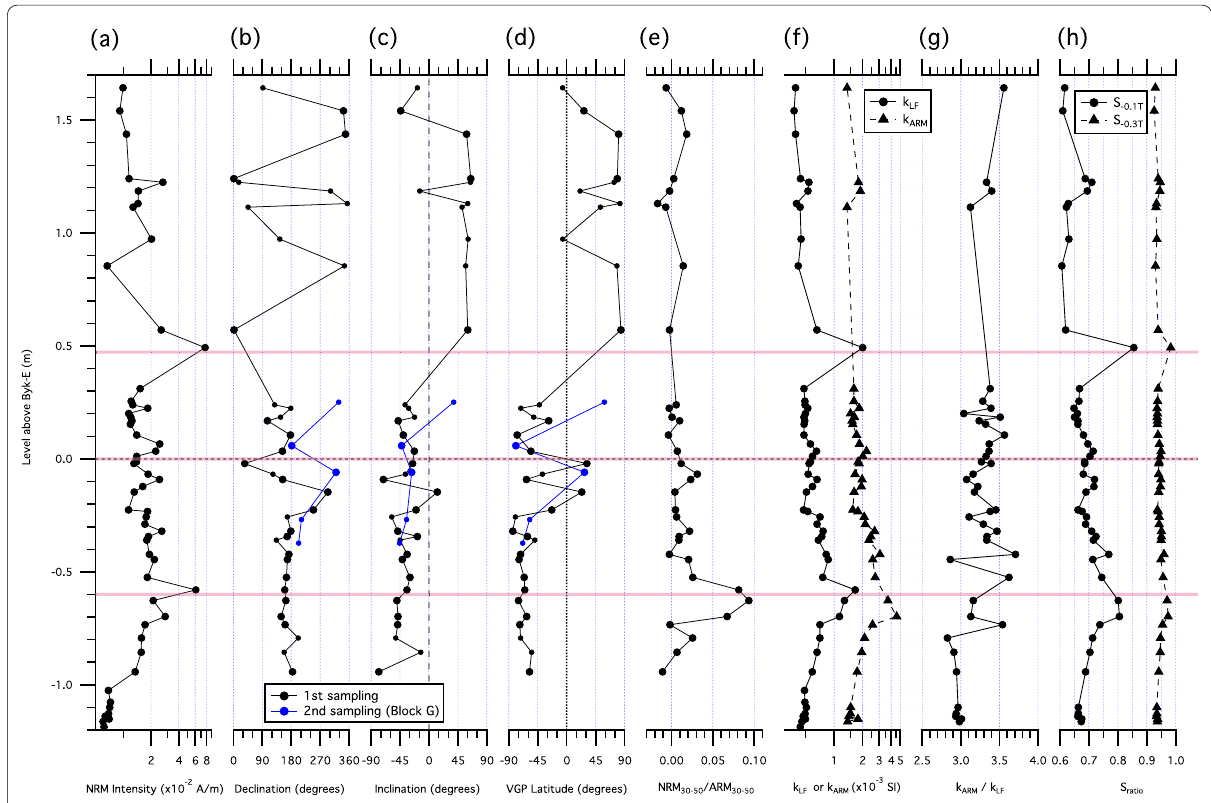
Fig. 14 Paleomagnetic results of combined analyses (Additional file 7: Table S2) plotted versus level above or below the Byk-E key tephra layer (corrected for the slope of the outcrop) together with various rock magnetic parameters. From left to right, a NRM intensity, b declination, c inclination, d VGP latitude, e relative paleointensity, f k LF (solid circles) and k ARM (solid triangles) g k ARM / k LF , h S ratio ( S circles and solid triangles, respectively). Black symbols are the results for the 1 st sampling and the blue ones are those for the 2nd sampling (Block G in Additional file 3: Figures S3(c) and S4(e)). In b – d , reliability categories are expressed by the size of the symbol (the largest is the most reliable category ‘3’). Horizontal pink lines are tephra layers, which correspond to tephra A, Byk-E tephra, and tephra C from top to bottom, respectively